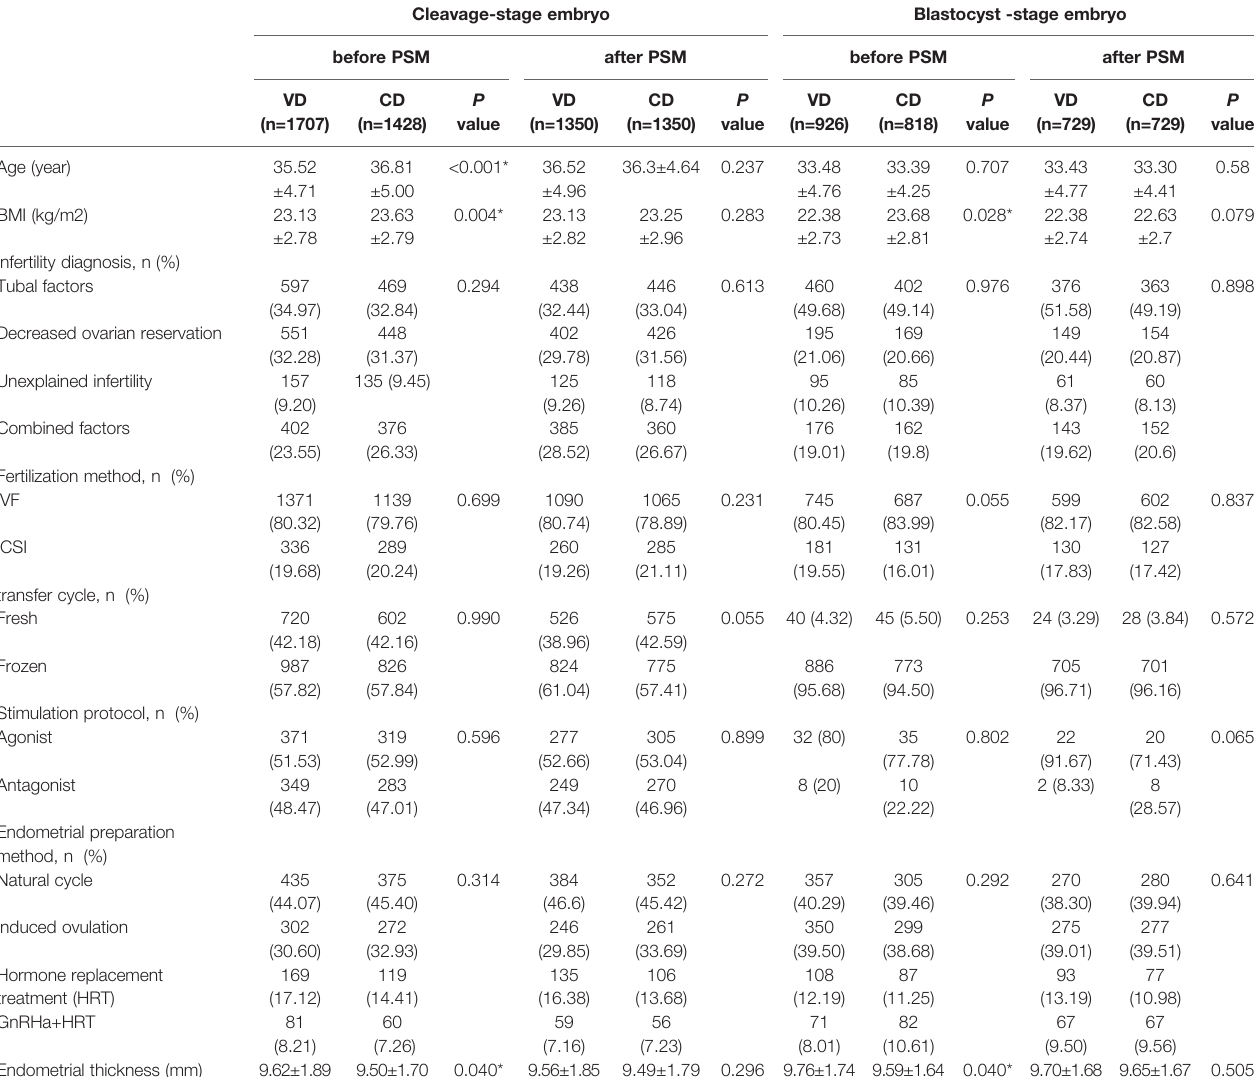
TABLE 1 | Demographics and cycle characteristics of patients with different previous delivery modes. Cleavage-stage embryo Blastocyst -stage